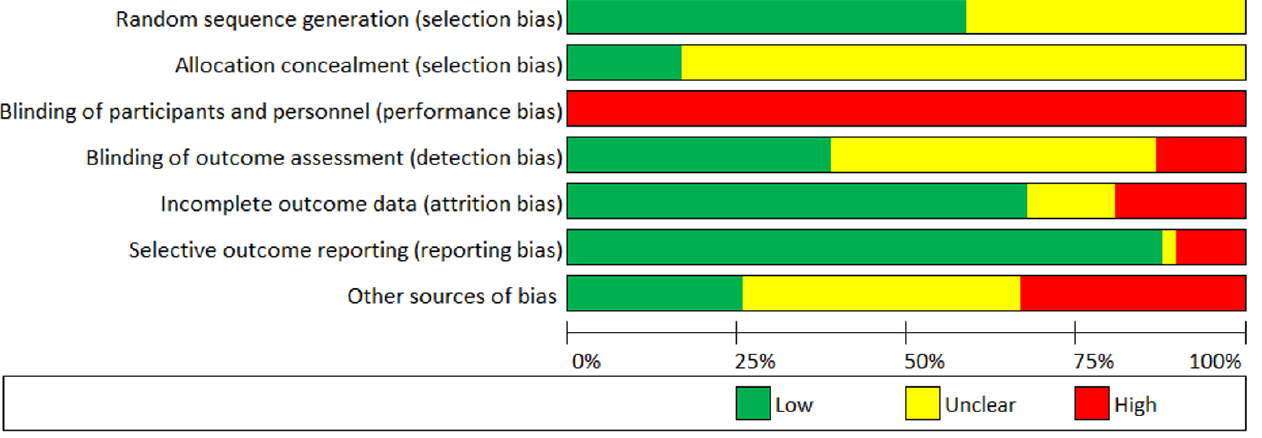
meta-analysis of depressive symptoms and attrition.